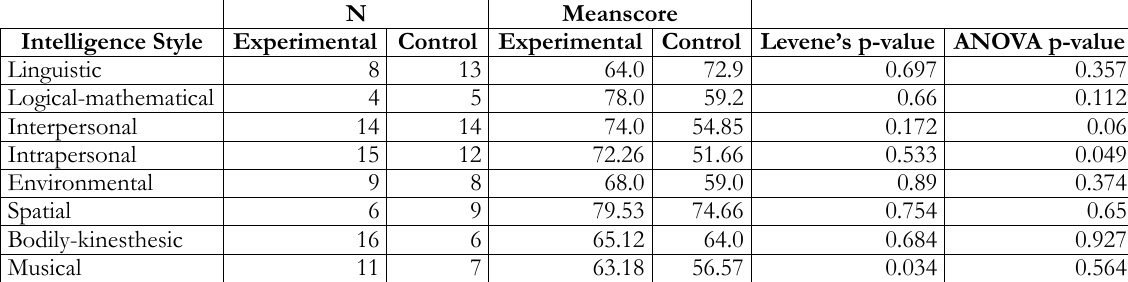
Table 3. Content acquisition ANOVA post-test results segmented by Intelligence